Question: What caption would you write for this figure?
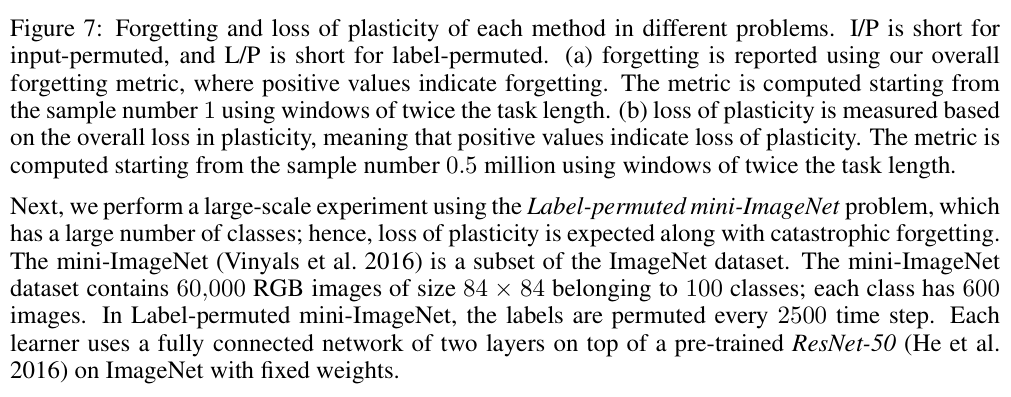
Answer: (b) shows that methods addressing catastrophic forgetting, including UPGD-W but except S-RWalk and S-SI, keep improving their performance and outperform methods that only address loss of plasticity. Notably, we observe that S-RWalk, which addressed catastrophic forgetting in the previous problem, struggles in this problem, likely due to the additional loss of plasticity. On the other hand, the performance of S-SI and the rest of the methods keeps deteriorating over time.